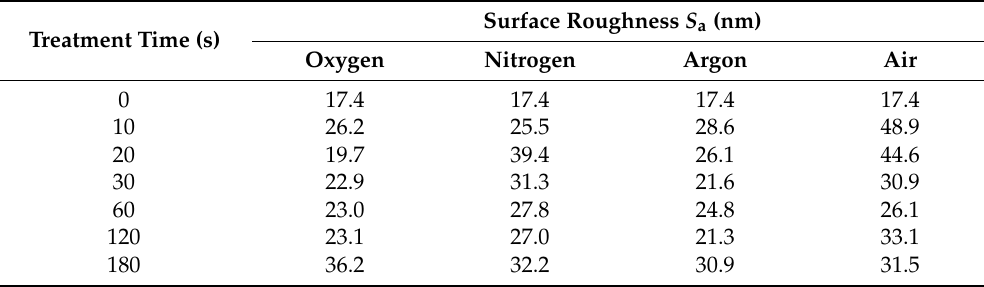
Table 2. Surface roughness of plasma treated LDPE.